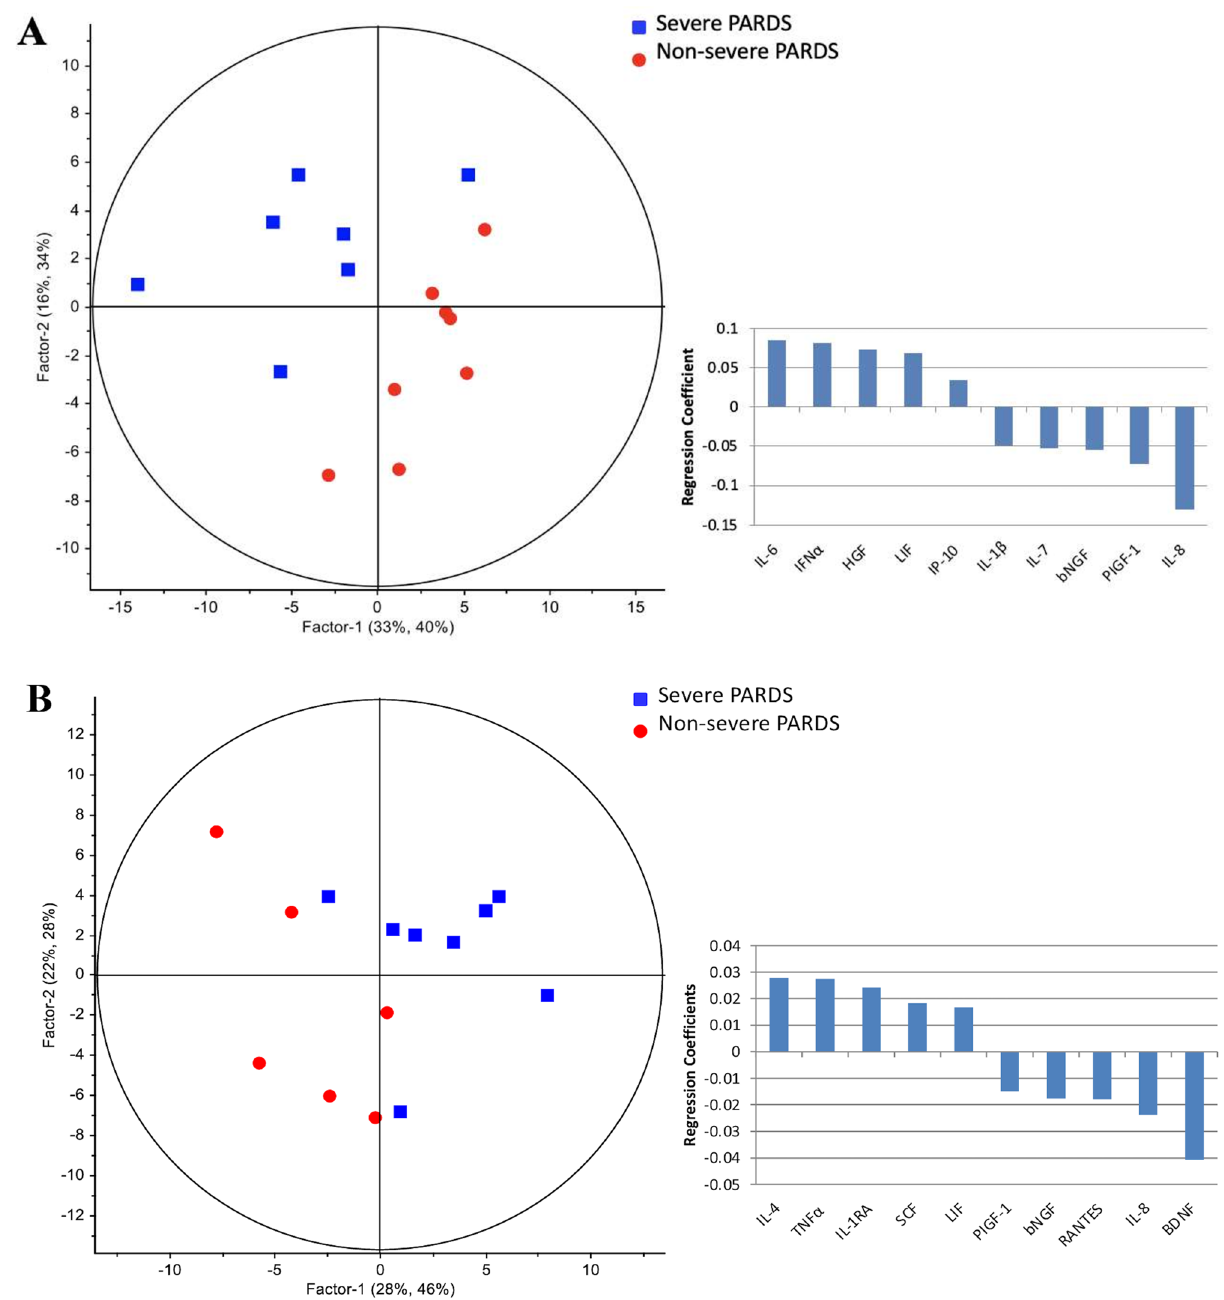
Figure 4. Plasma cytokines showed distinct segregation between non-severe and severe PARDS in the partial least squares regression model (left) in early ( A ) and late ( B ) timepoints of disease. Regression coefficient plots identifying the top ten plasma cytokines associated with severe PARDS